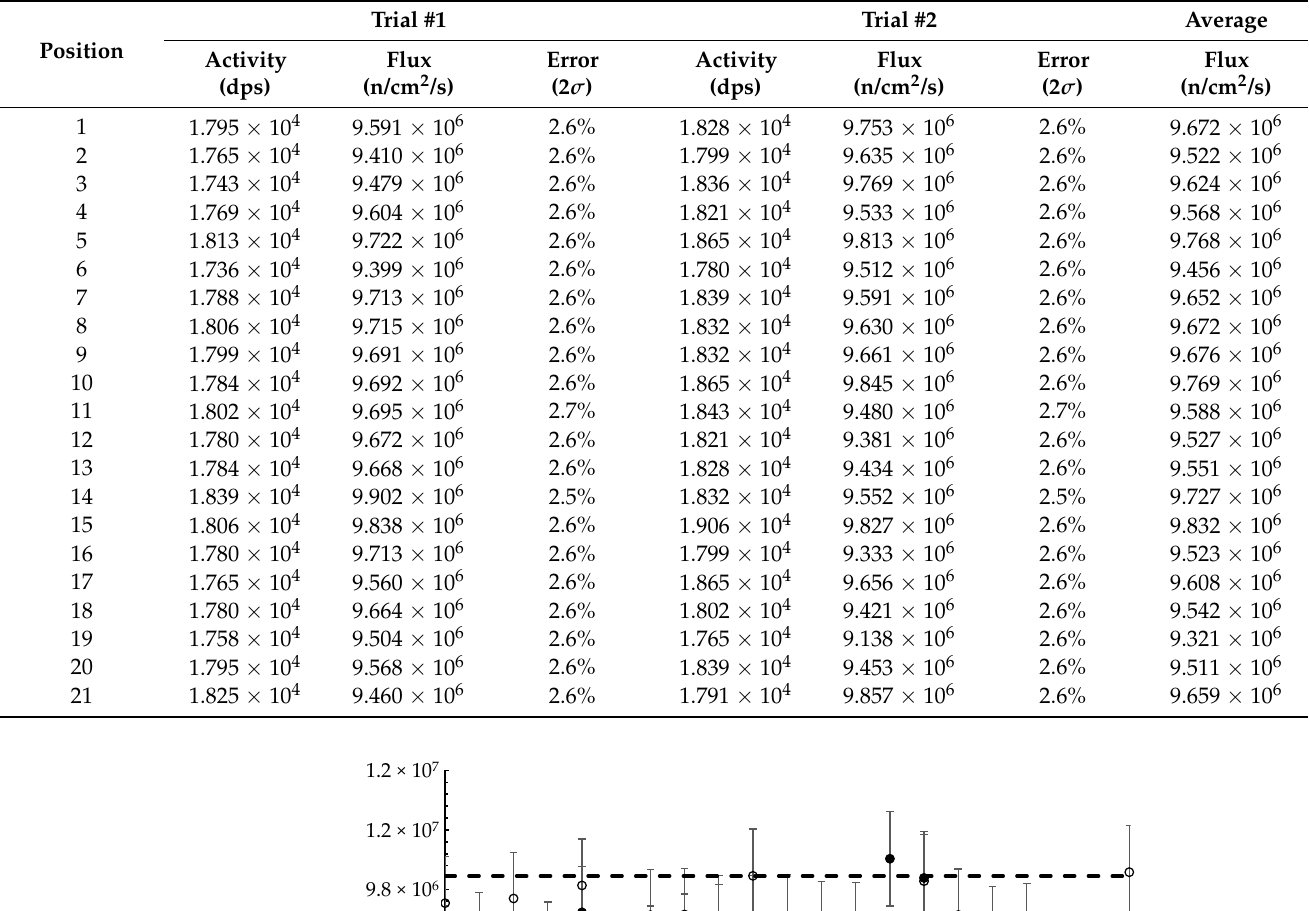
Table 5. Neutron flux measurements at the image plane (ERS).